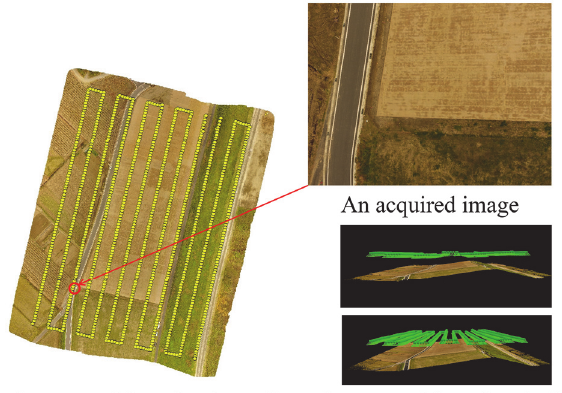
Figure 13. Flight number 4 by Phantom 4